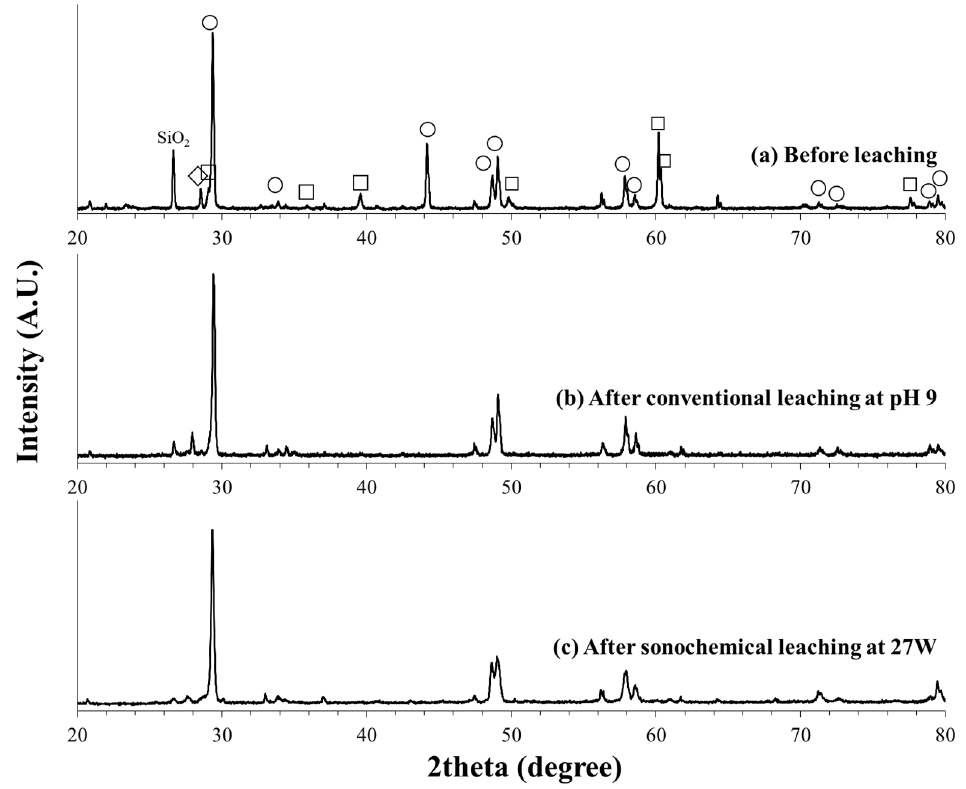
Figure 3. XRD patterns of bulk concentrates before and after leaching (current density: 0.292 A/g, pulp density: 5%, temperature: 25 °C, pH 9, ultrasonic power: 27 W).